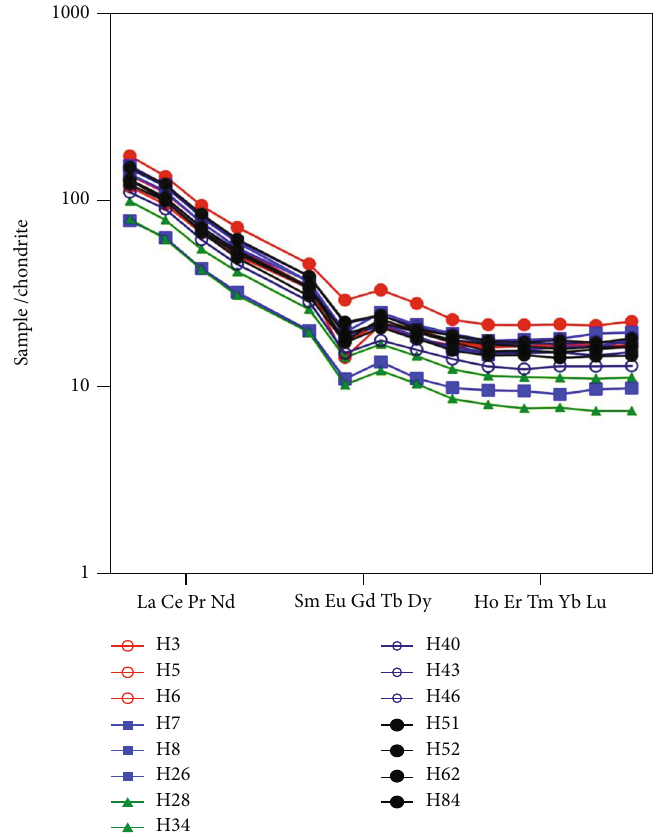
Figure 10: Chondrite meteorite standard distribution pattern of Daping gold deposit. The values for chondrite are from